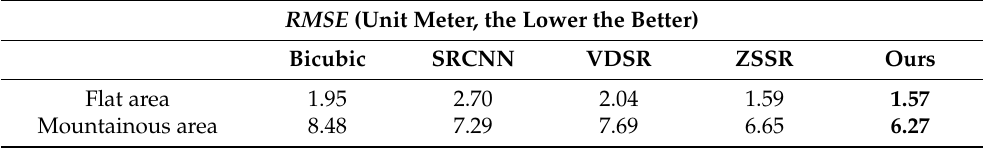
Table 9. Values of RMSE for different super-resolution reconstruction methods in flat areas and moun- tainous areas of test datasets from the training region and outside the training region, respectively. RMSE (Unit Meter, the Lower the